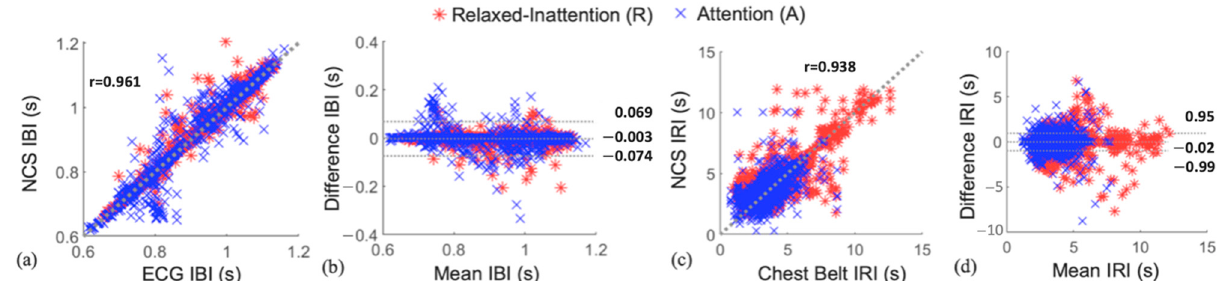
Figure 5. Comparison of NCS and reference IBI and IRI data from all participants during relaxed– inattention and attention routines. ( a , c ) The IBI and IRI scatter plots with denoted Pearson’s correlation coefficients; ( b , d ) The Bland–Altman plots showing the mean difference m at the center dotted line and the corresponding LoA.